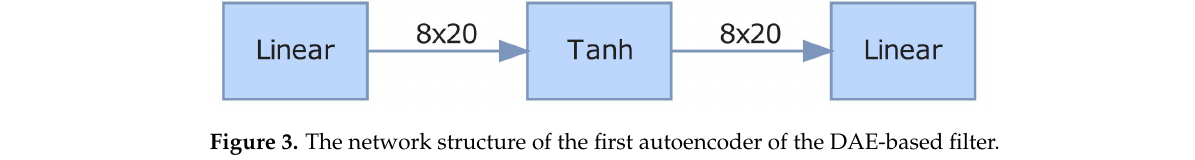
Figure 4. The network structure of the second autoencoder of the DAE-based filter.